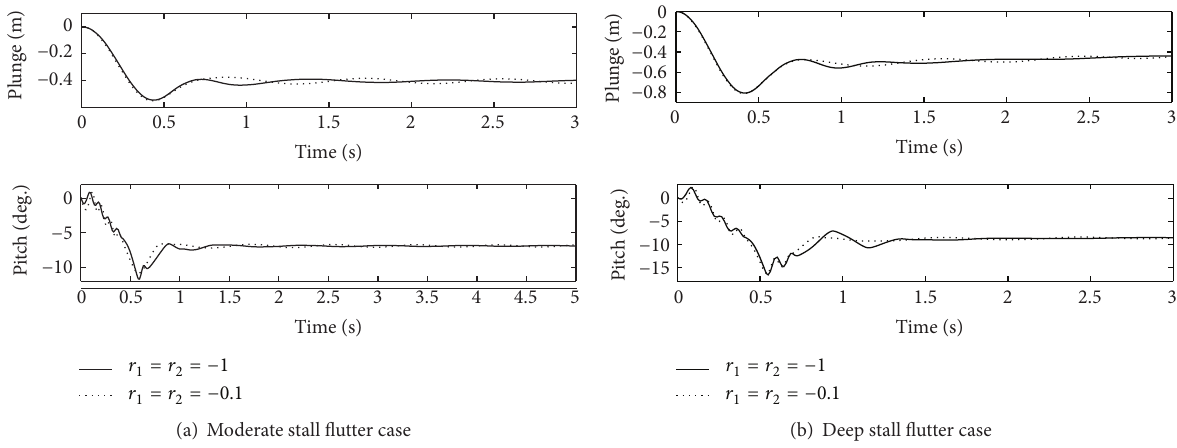
Figure 14: Adaptive stall flutter control responses with different equal-weigh control strategies for (a) moderate stall flutter case and (b) deep stall flutter case.